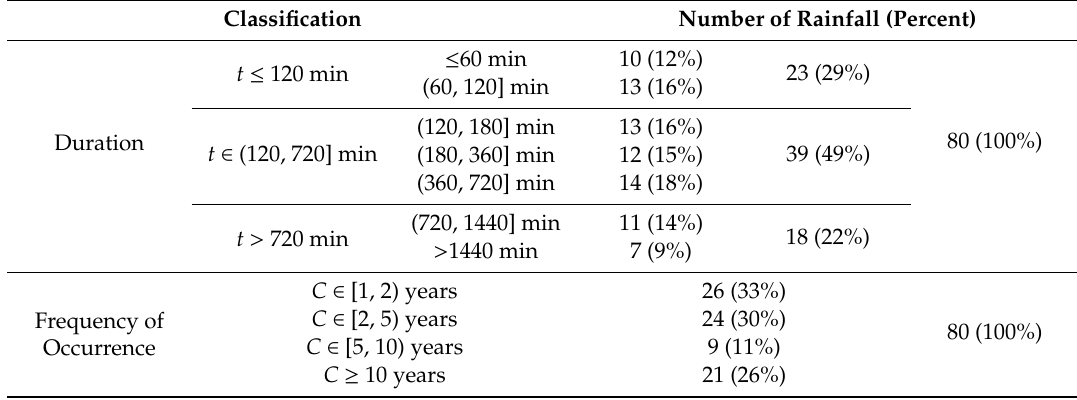
Table 1. Number of precipitations in separate time groups and exceedance classes. Classification Number of Rainfall